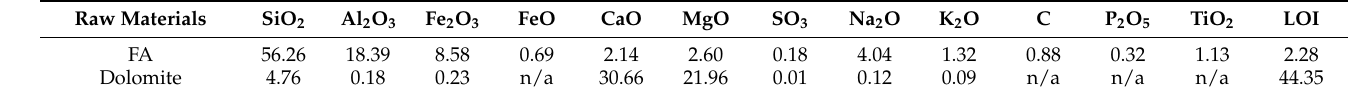
Table 1. Chemical compositions of the FA and dolomite, wt.%. (n/a—not analyzed). Raw Materials